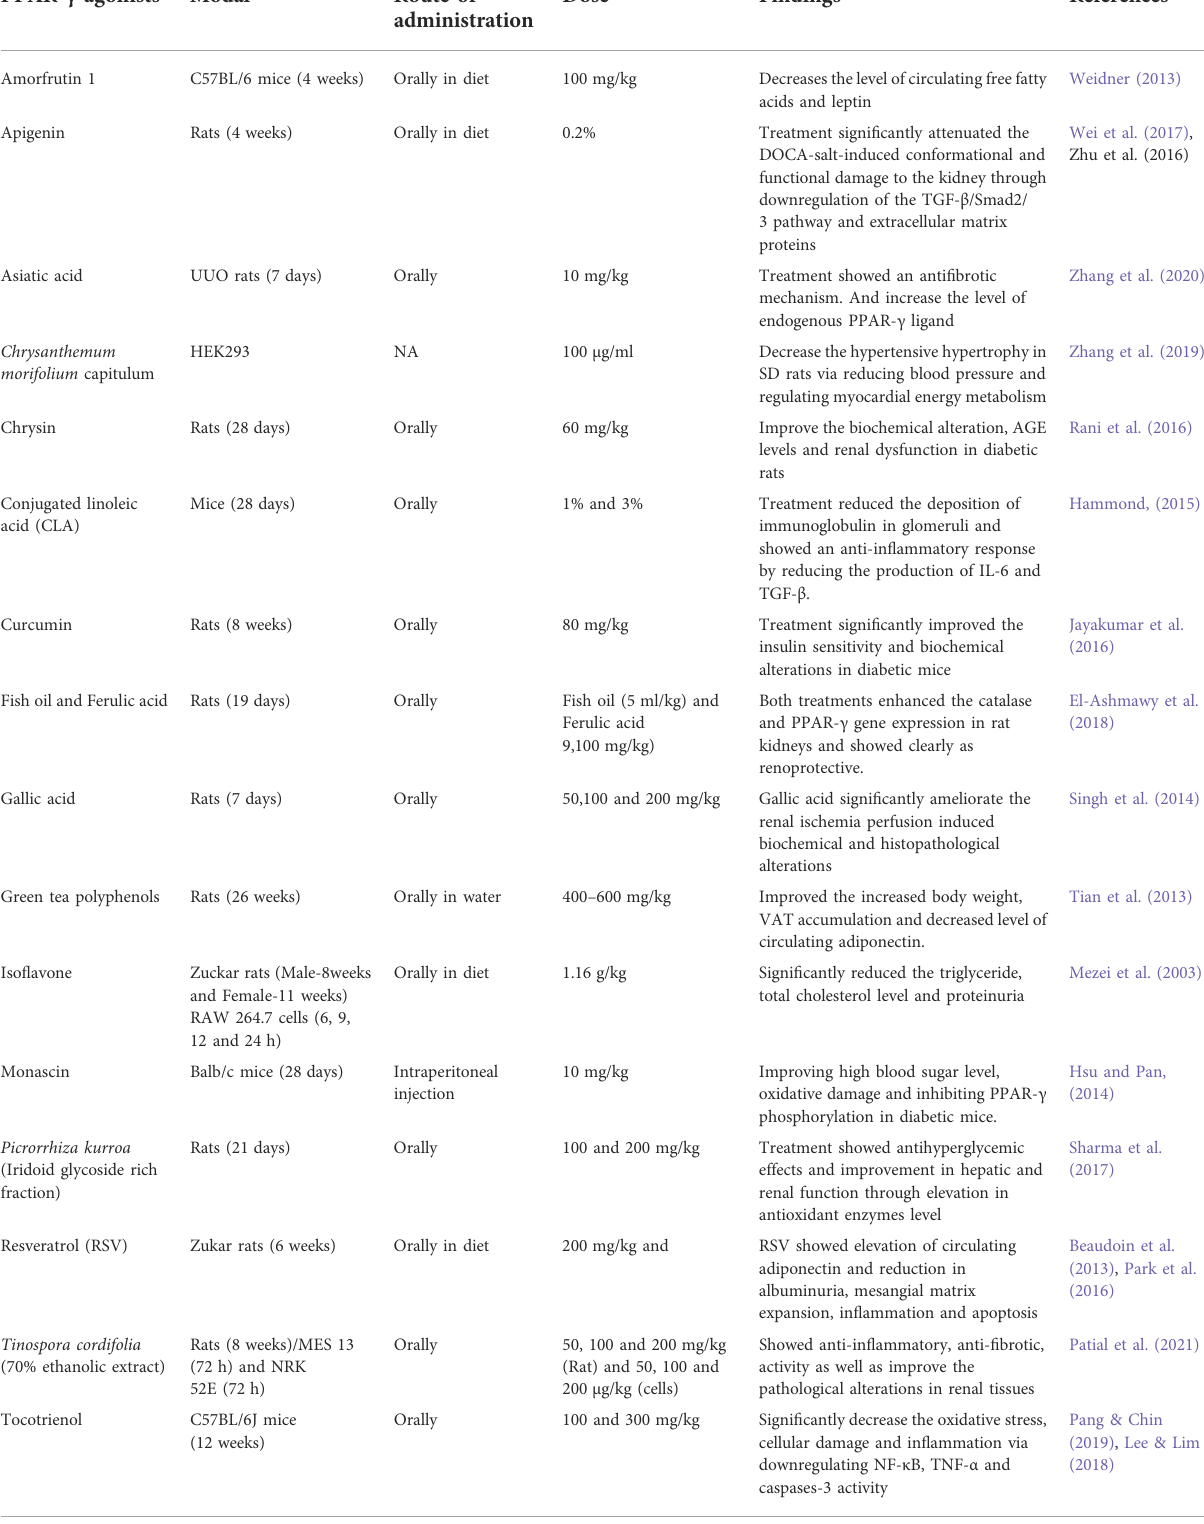
TABLE 1 Natural PPAR- γ agonists and their effect on kidney cells in vitro and in vivo